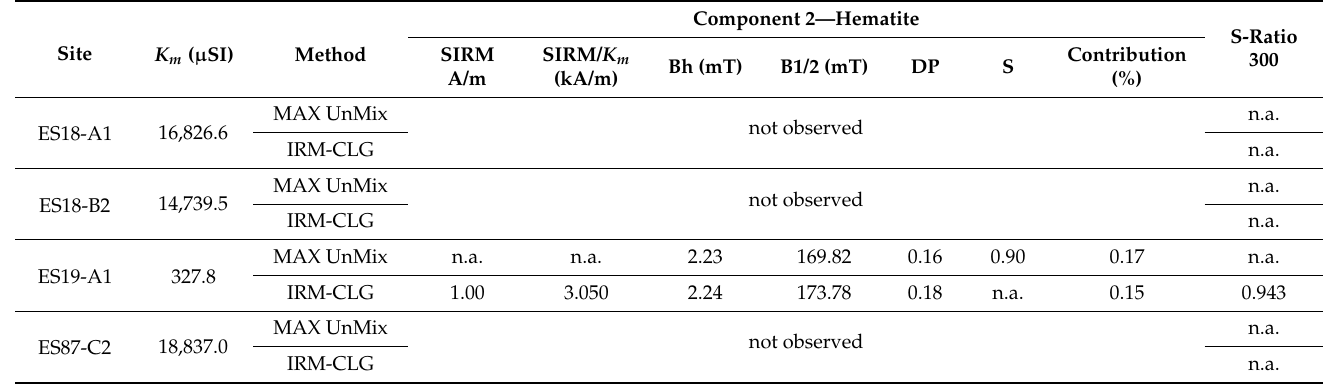
Table 2. Isothermal remanent magnetization data from the second component of the studied sam- ples. The Cumulative log-Gaussian (CLG) treatment allows the determination for each magnetic component: K m : magnetic susceptibility; SIRM: saturation of isothermal remanent magnetization; Bh: coercivity (log(B1/2)); B1/2: field at which half of the SIRM was reached; DP: dispersion